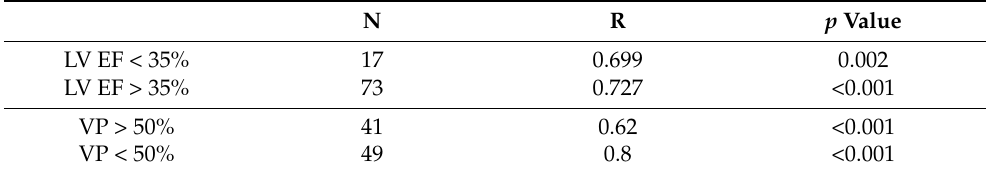
Table 3. 2D and 3D global longitudinal strain, subgroup analysis.